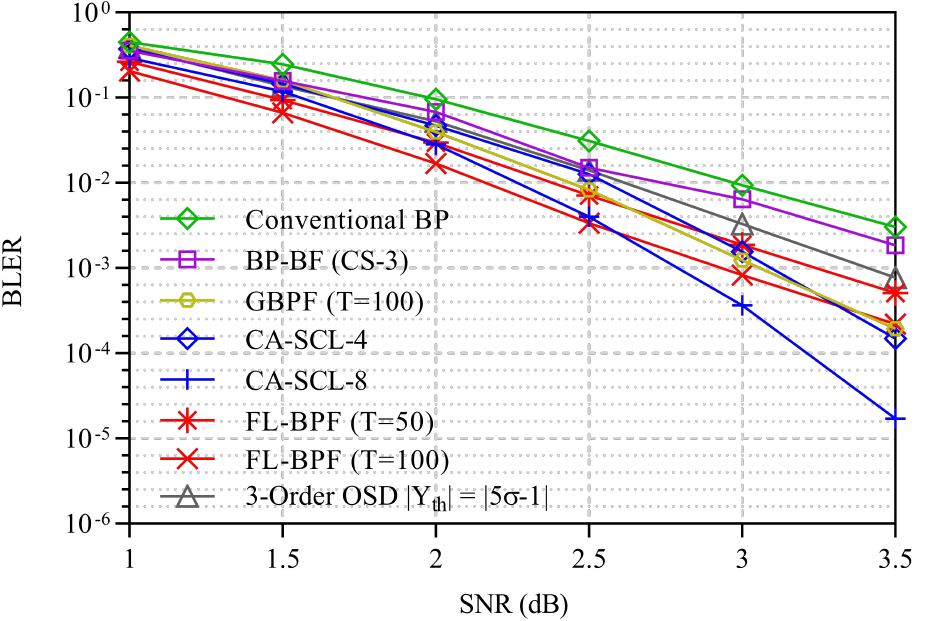
Figure 4. BLER performance of BP, BP bit-flip (BP-BF(CS-3)), generalized BP-flip (GBPF), CRC-aided successive cancellation list (CA-SCL), and the proposed technique for P ( 256,128 )